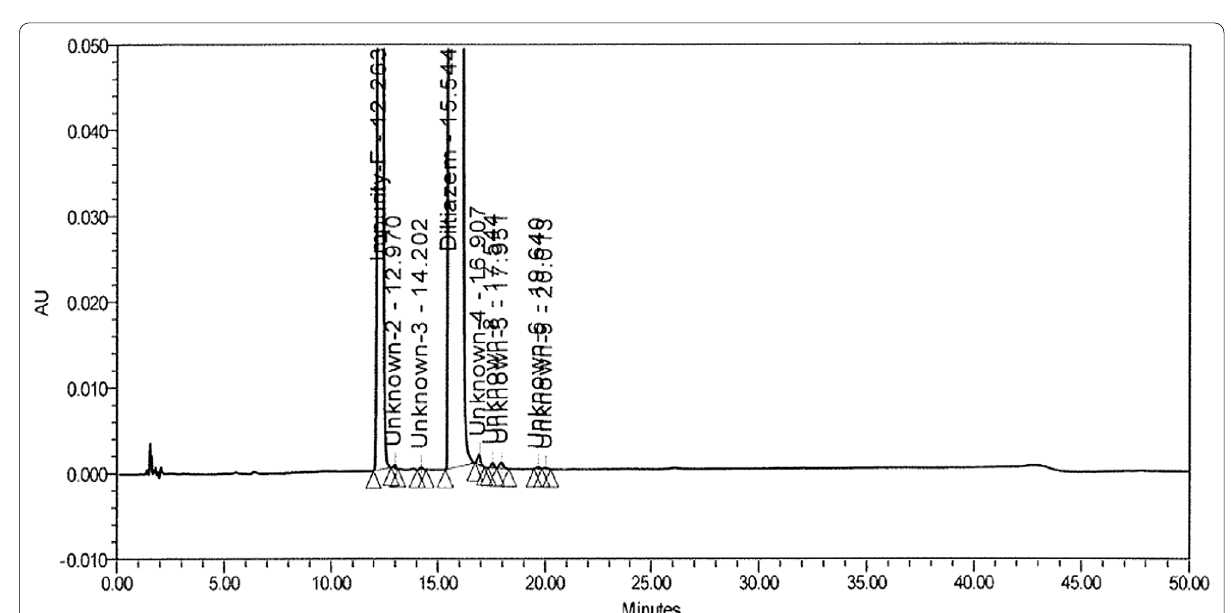
Fig. 12 Typical HPLC chromatogram of alkaline degradation